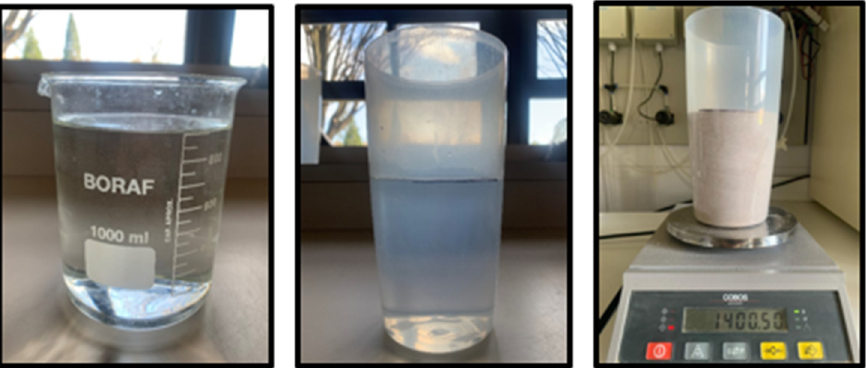
Figure 5. Steps for determining the volumetric moisture. One liter of water was measured and poured into the container where the probe measurements were placed. That volume was marked with a sharpie and filled with